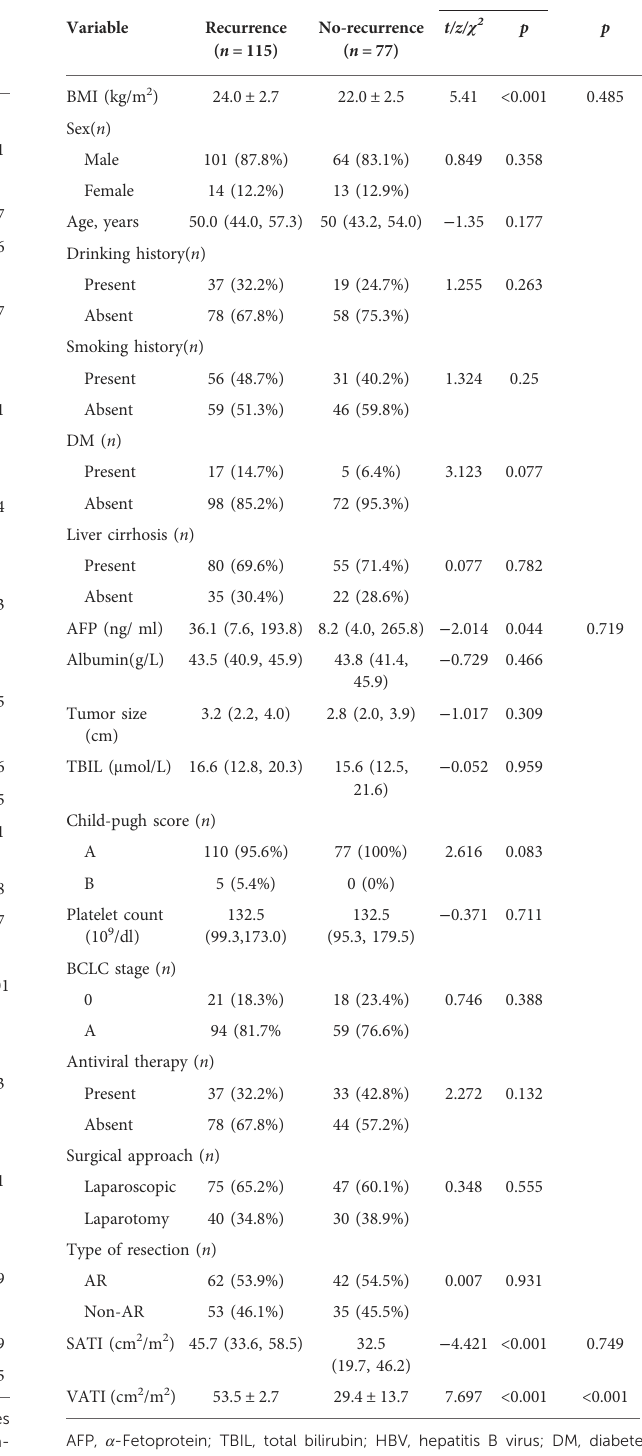
TABLE 1 Baseline characteristics of the patients. TABLE 2 Risk factors for early recurrence after